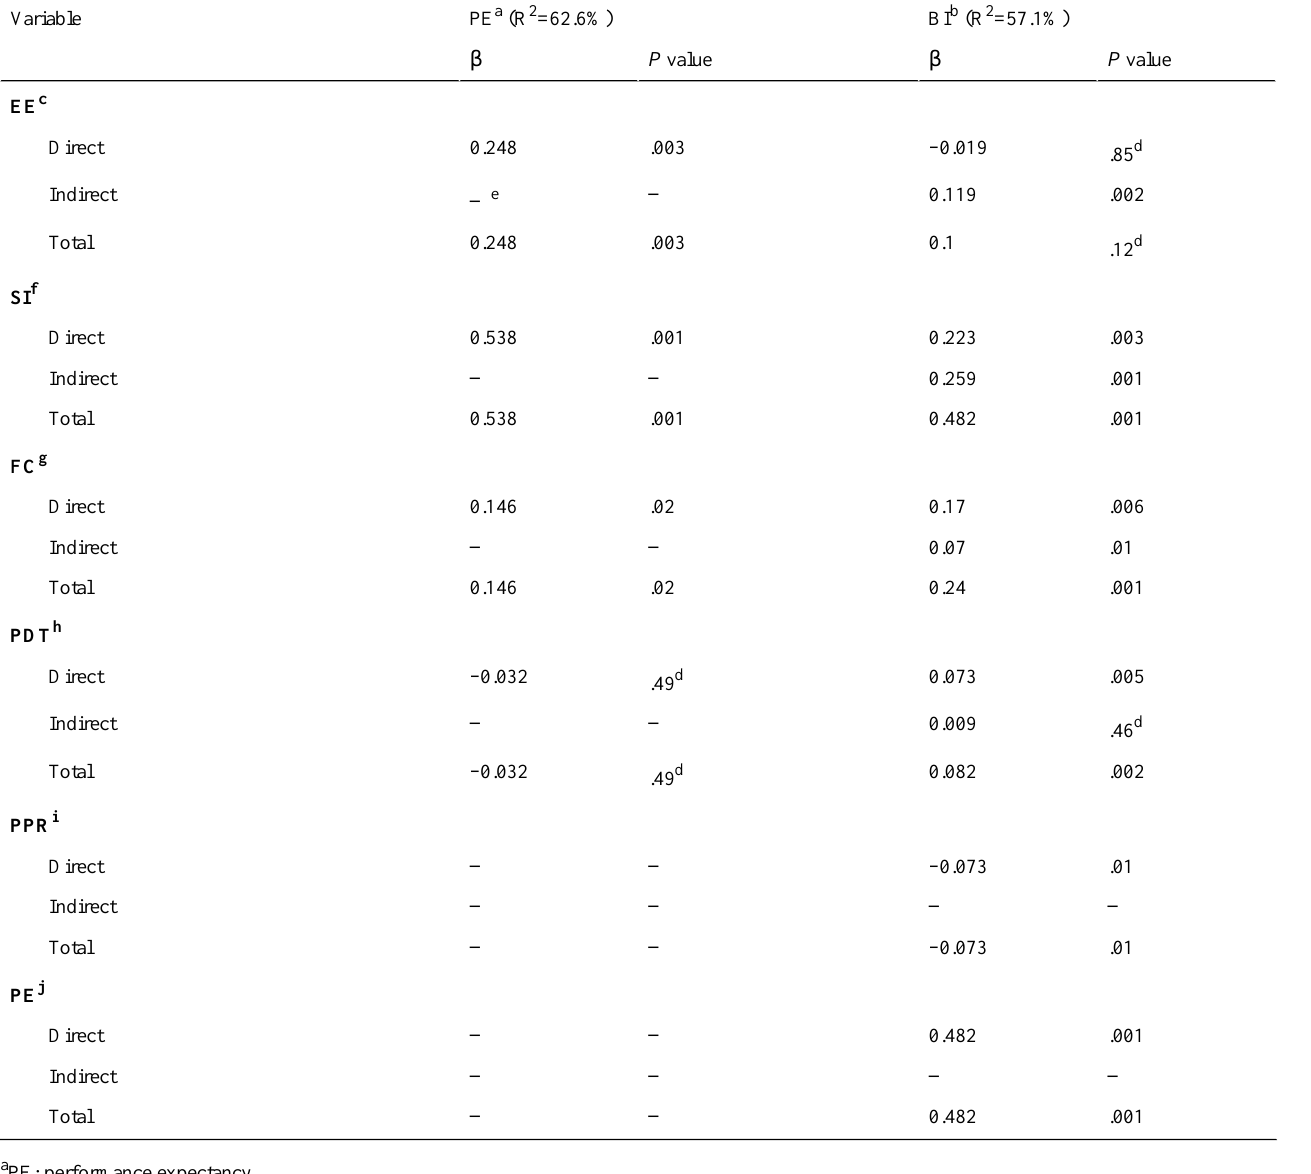
Table 7. Standardized regression weights between the model